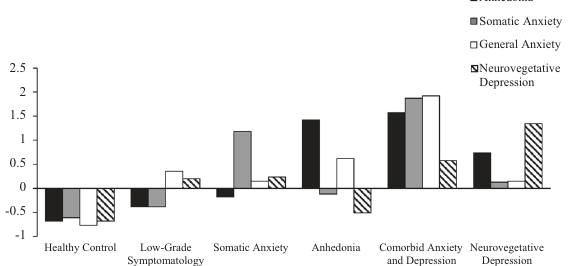
Fig. 1 Symptom cluster solution among mean standardized PCA dimension scores. This comprised six clusters including healthy control, low-grade symptomatology, somatic anxiety, anhedonia, comorbid anxiety and depression, and a neurovegetative depres- sion